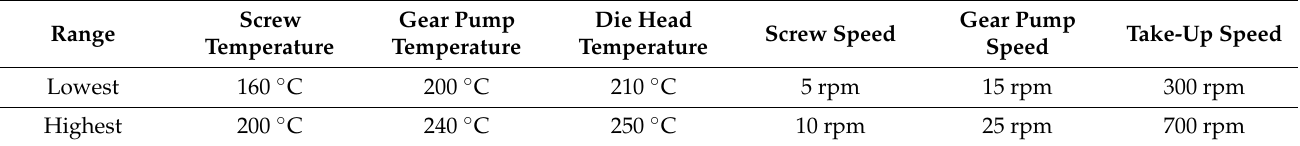
Table 1. The range of melt spinning machine processing parameters.